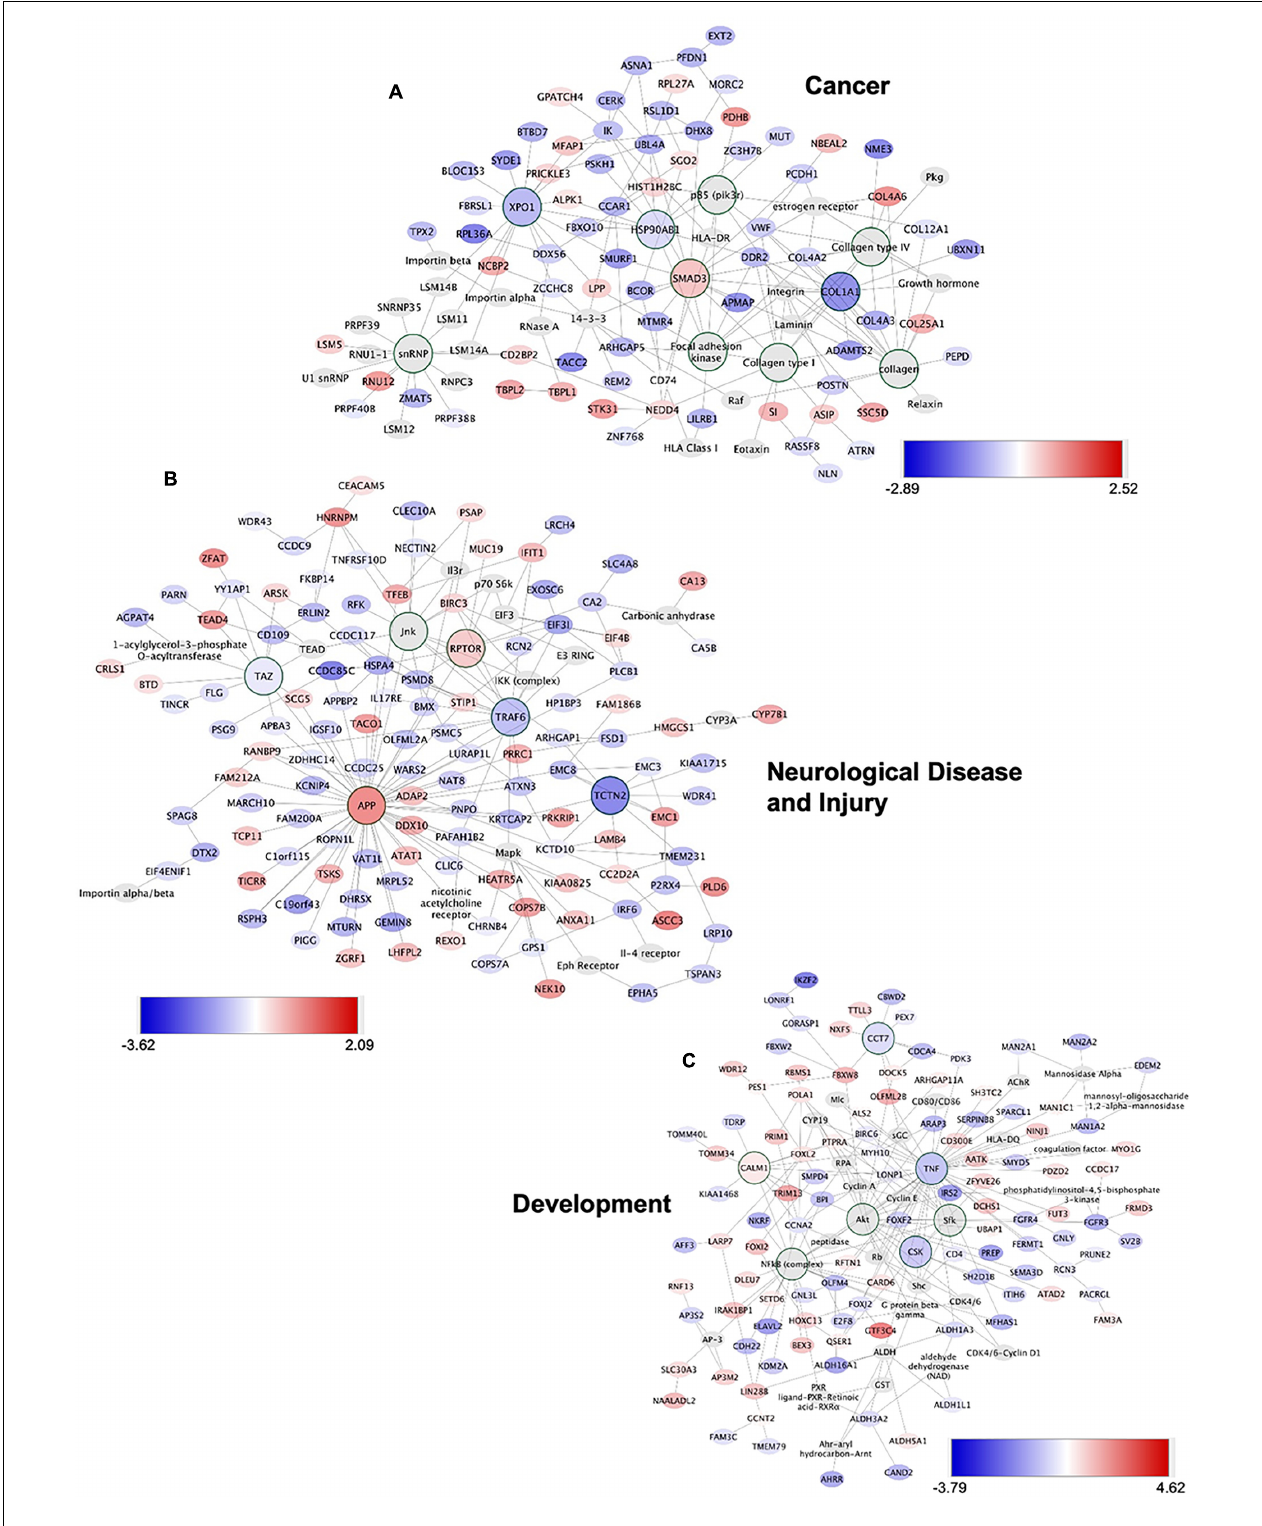
FIGURE 12 | Gene network analysis of highly repetitive classes of coordinated diseases and functions from the Stroke-MET transcriptome. Network of gene interactions representing genes associated with “cancer” (A) , “Neurological disease and injury” (B) , “Development” (C) . Red: upregulated genes, blue: downregulated genes, and larger nodes: central and highly connected genes. Nodes shown in gradients of red and blue are up- and down-regulated, respectively. Centrality values are provided in the Table 2 . Central genes with higher connectivity with neighboring genes are shown as larger nodes in each category.